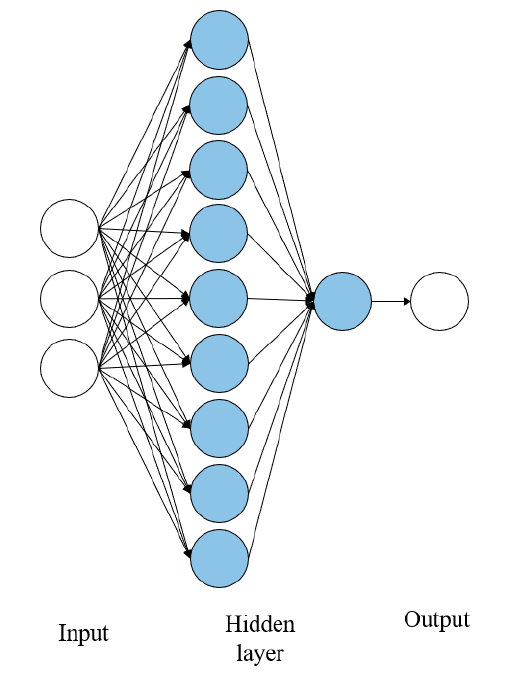
Figure 4. ANN structure for three input parameters (P1 + P2 + P3).